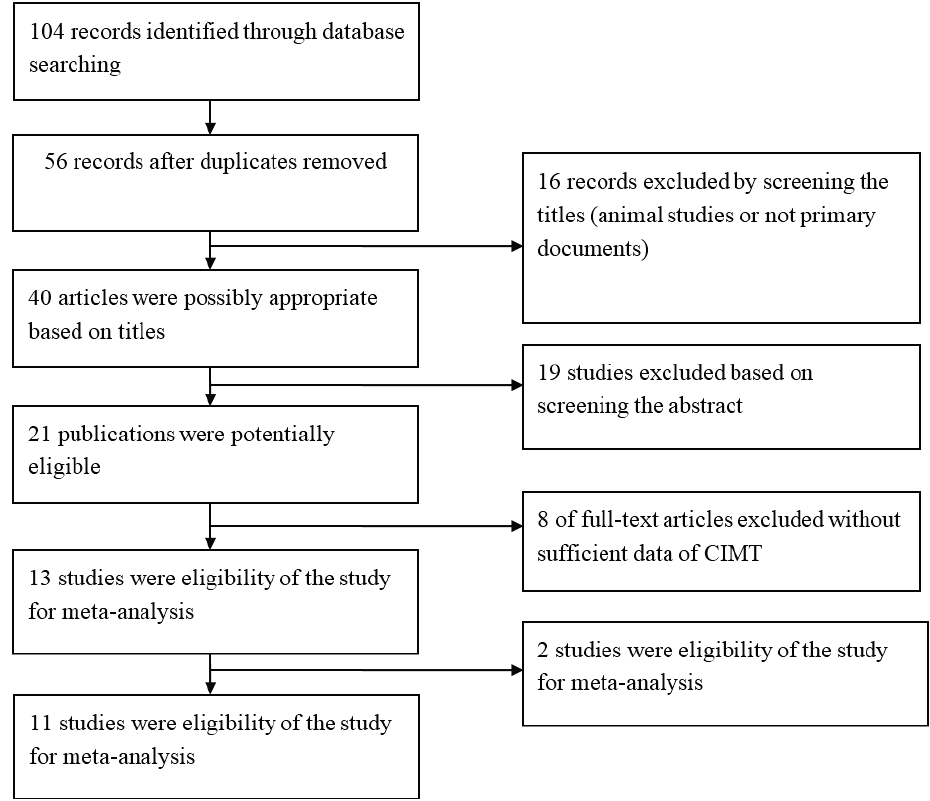
Figure 1. Flow chart of studies selection in the